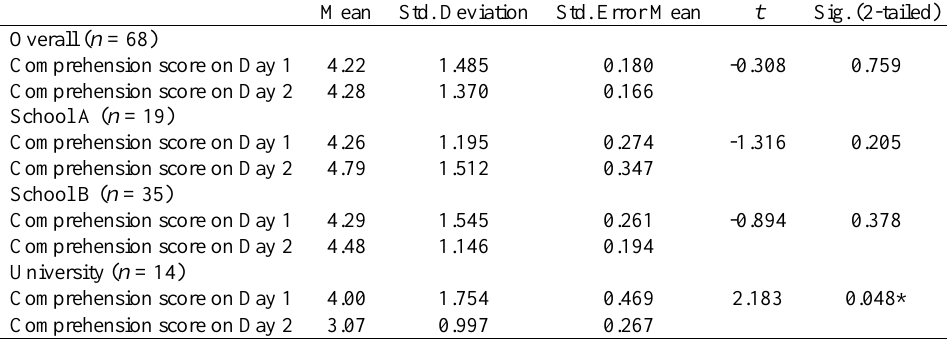
Table 5 Comprehension score on Day 1 and Day 2